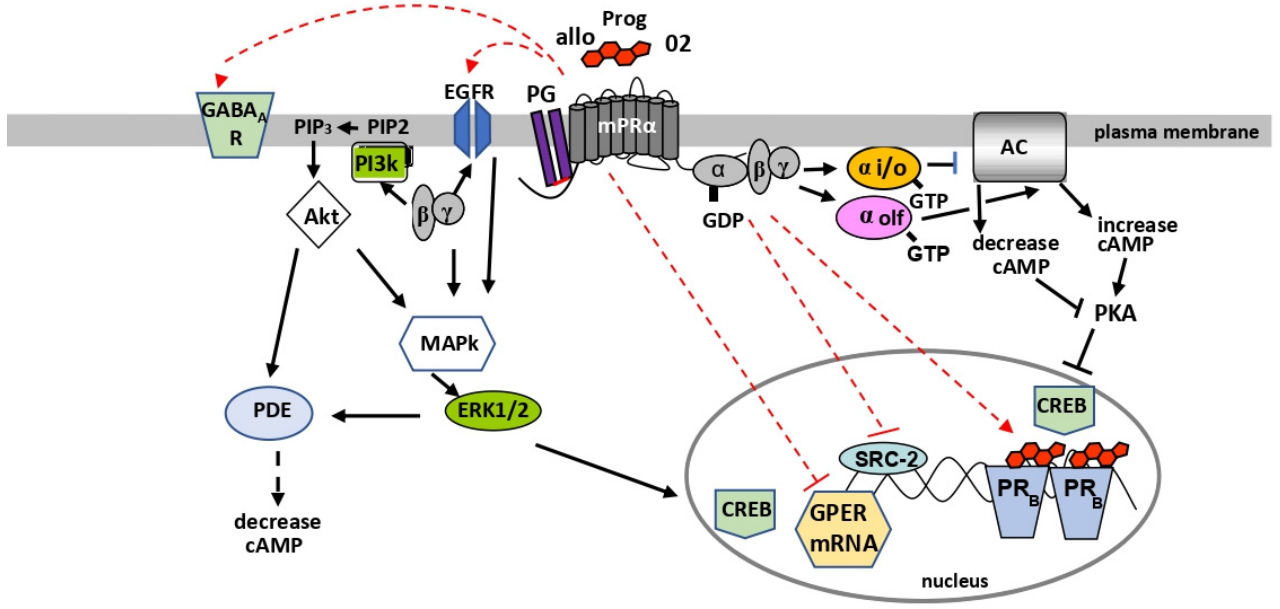
Figure 3. Current model of mPR α association with adaptor and G proteins, regulation of second messenger pathways (black), and regulation of other receptors (red). Hatched lines indicate intermediates/mechanisms of receptor regulation unknown.